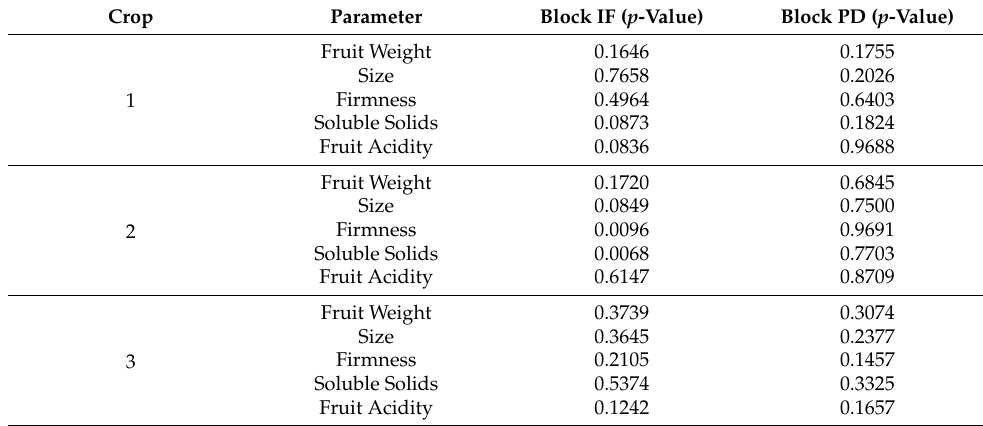
Table 7. Influence of Brassica carinata pellets (Crops 1 and 2) and tomato plant debris (Crop 3) on tomato fruit quality parameters in the IF and PD